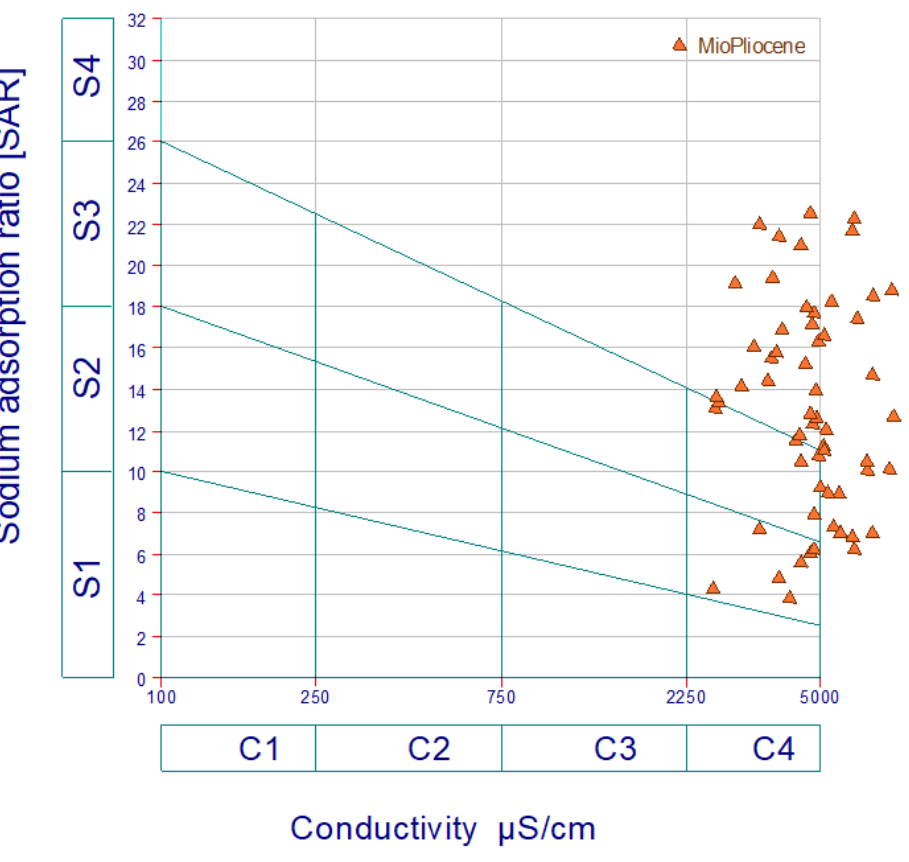
Figure 6. USSL diagram for EC and sodium percentage of groundwater suitability in irrigation.